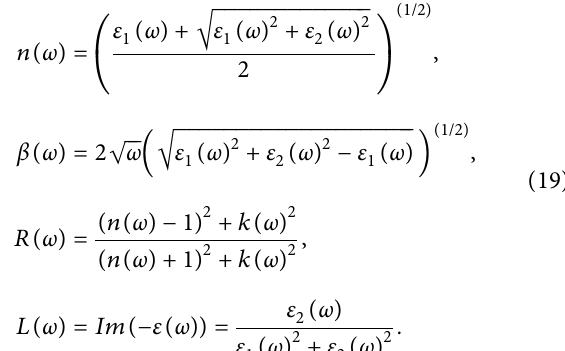
with respect to temperature 3